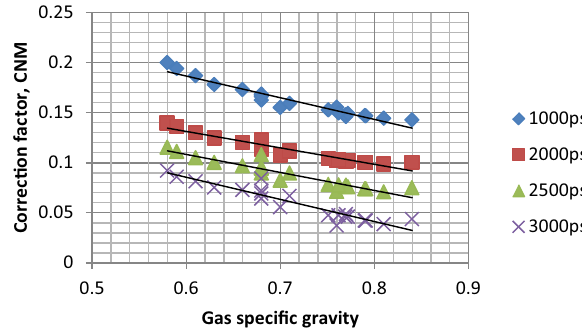
Fig. 11 Calculation of C NM at 300 (cid:3) F and different pressures